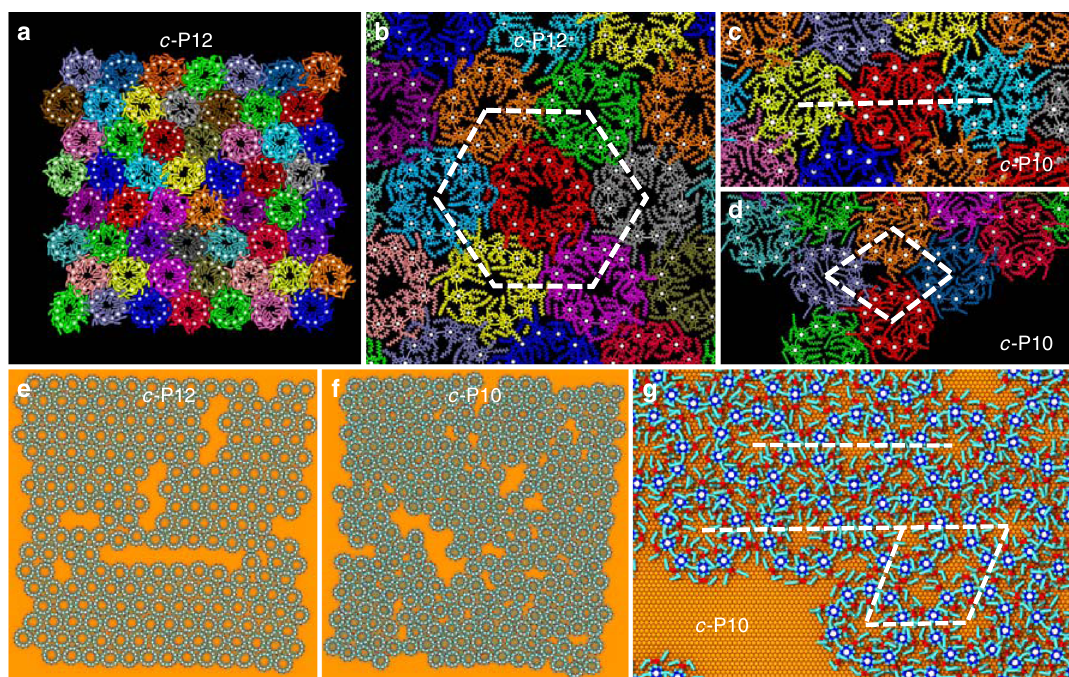
Fig. 4 Simulation snapshots of c -P10/12 nanorings. a Snapshot from an atomistic molecular dynamics (MDs) run of c- P12 aggregate. b Hexagonal arrangement of c- P12 nanorings. c Row and d rhombic packing of simulated c- P10 nanorings. e – g Snapshots taken from CG MD run of e c- P12 and f c- P10 aggregates. g Example of contiguous row and rhombic motif in c- P10